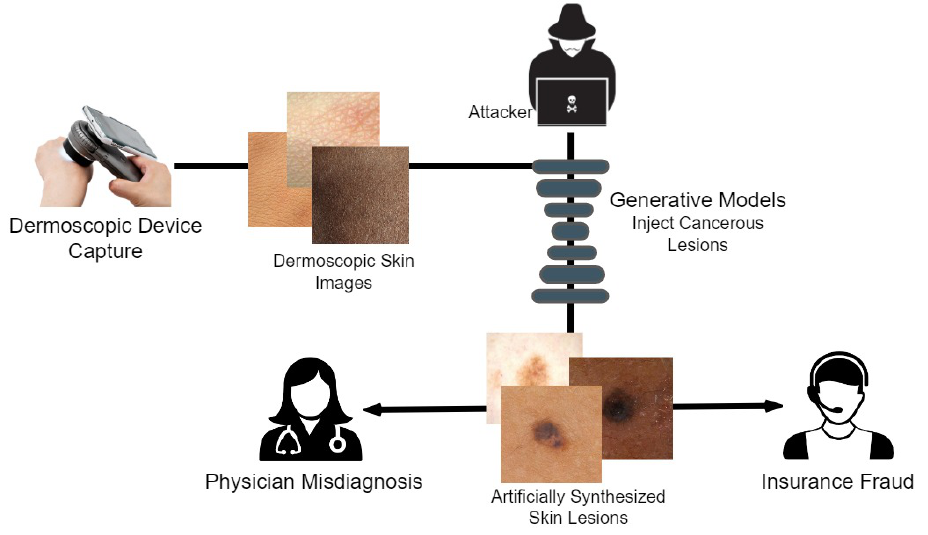
Figure 1. Behaviour of an attacker for Dermoscopic fakes to be used for the